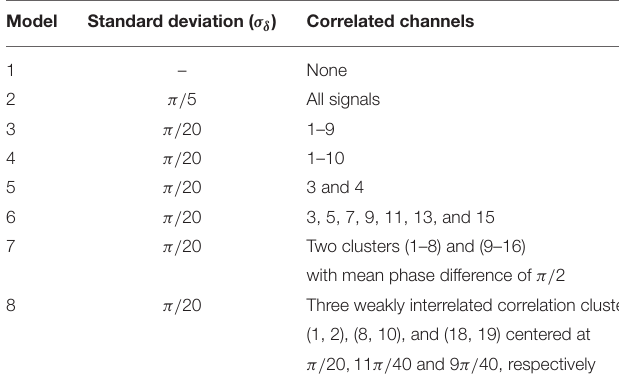
TABLE 1 | Correlation patterns generated by N f